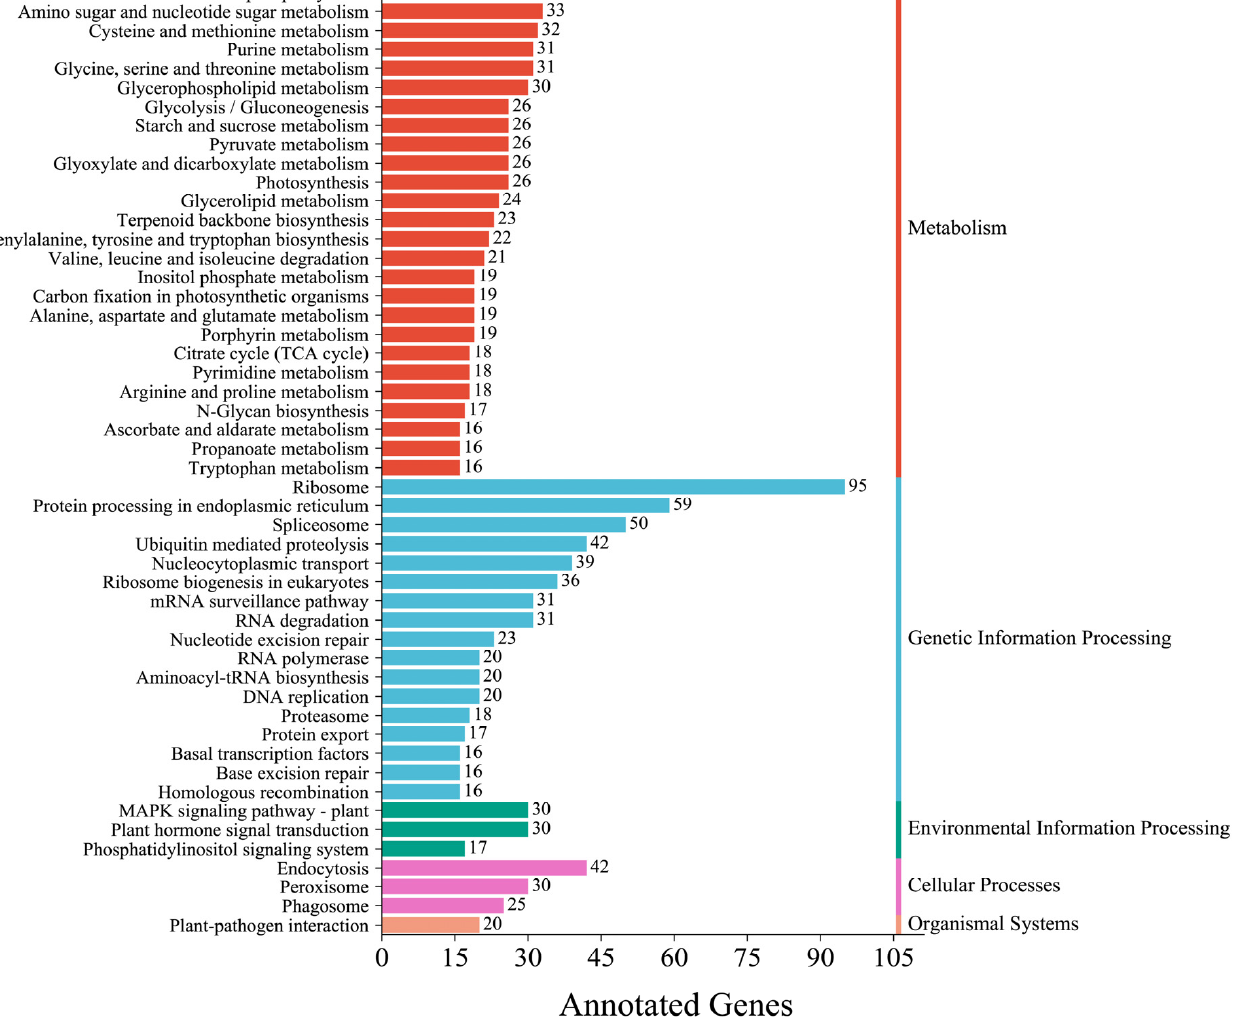
Figure 4. KEGG classification of C. macrophyllum .